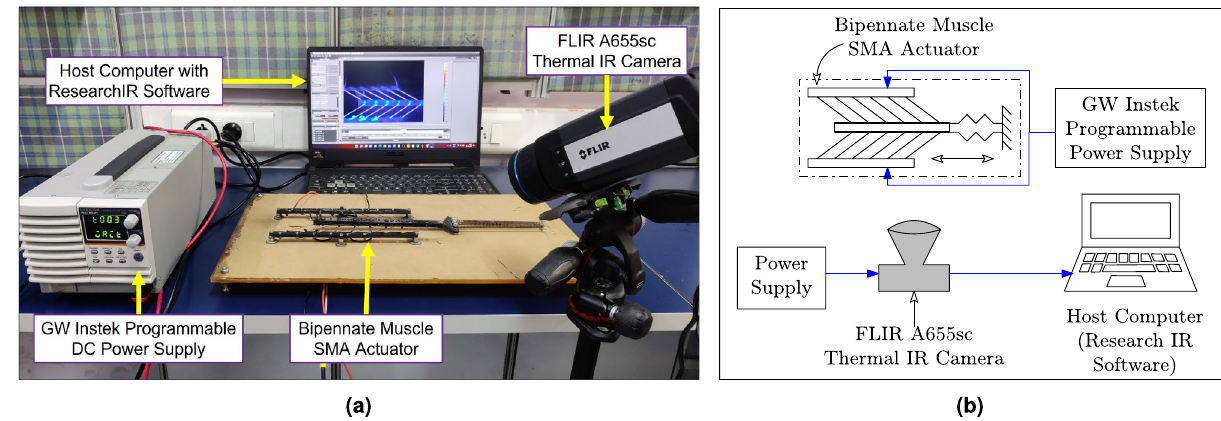
Figure 11. ( a ) The SMA-based linear actuation system was set up in an experiment to monitor the temperature of the SMA wire of the actuator. A 7 V voltage difference is applied throughout the full length of the cable using a GW Instek programmable DC power source. The actuator is kept in the focal plane of the FLIR A655sc Thermal IR camera to precisely monitor the closely packed SMA wires. ( b ) A schematic showing the circuit of the components of the thermal imaging experimental